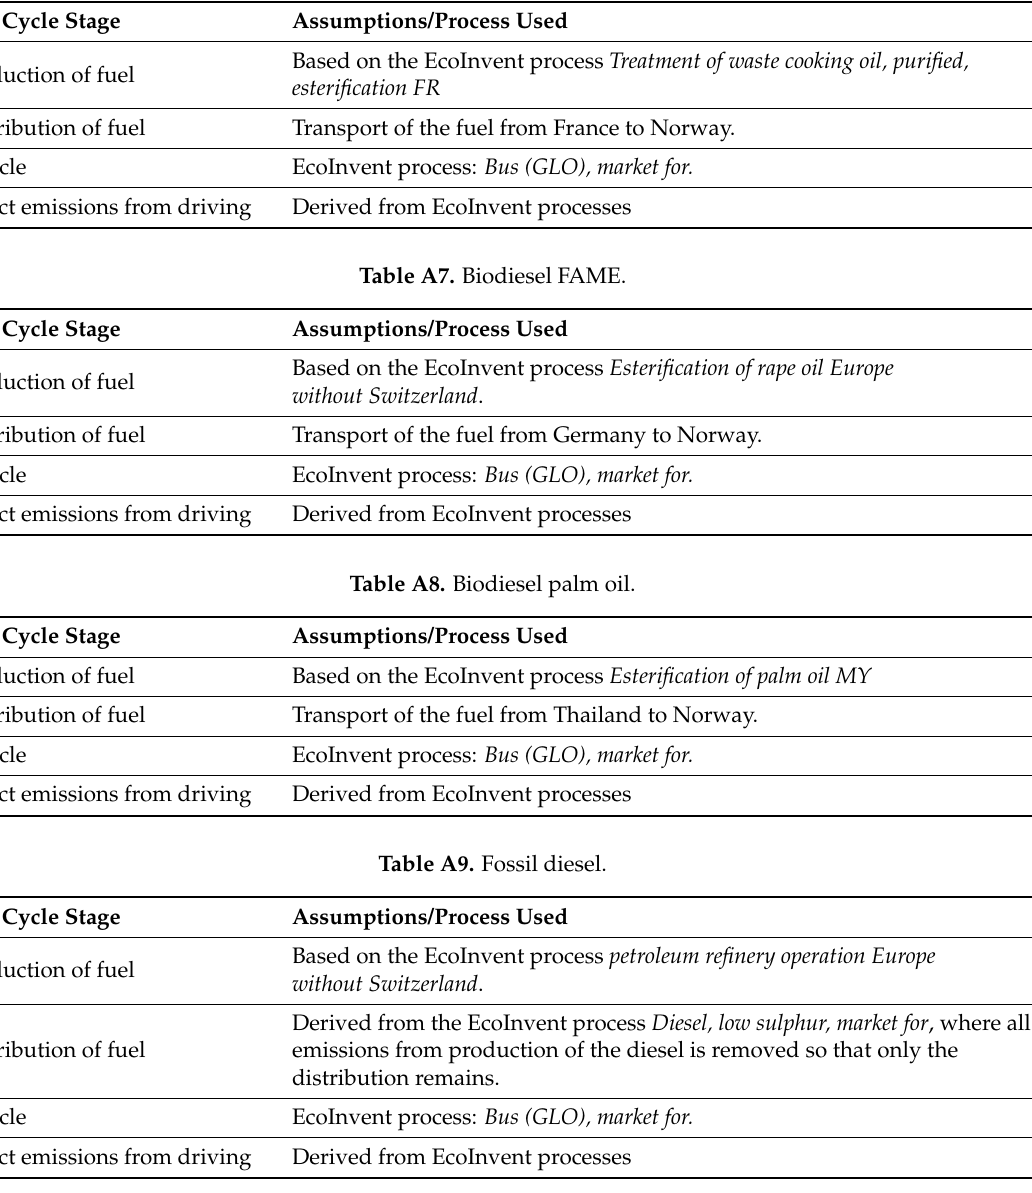
Table A6. Biodiesel HVO.